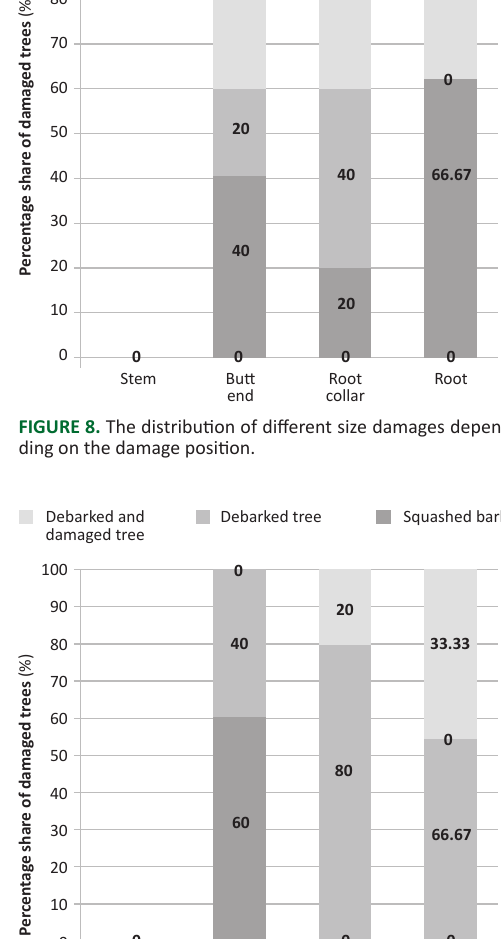
FIgURe 9. The distribution of different types of damages depending on the damage position.